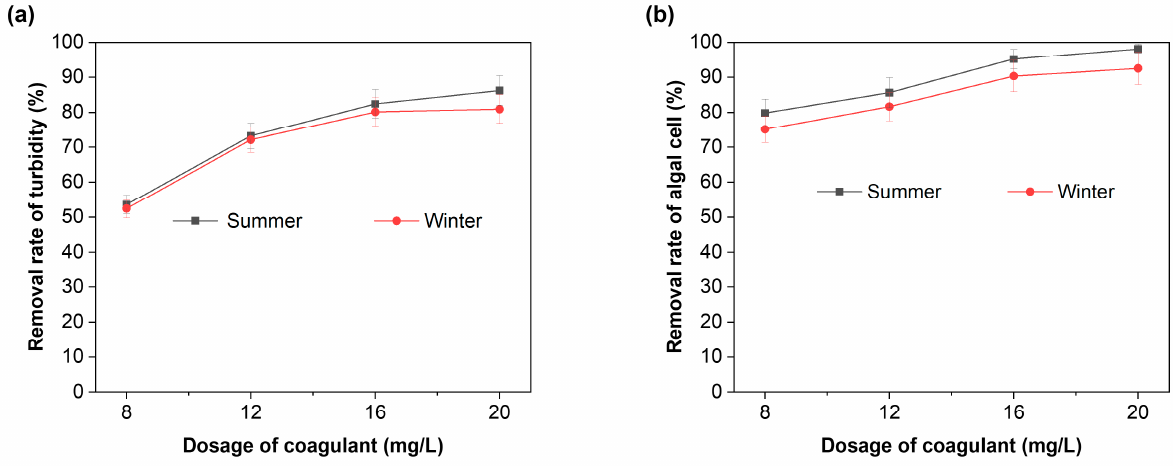
Figure 7. The turbidity removal rates ( a ) and algal cell removal rates ( b ) for the water resources in different seasons.